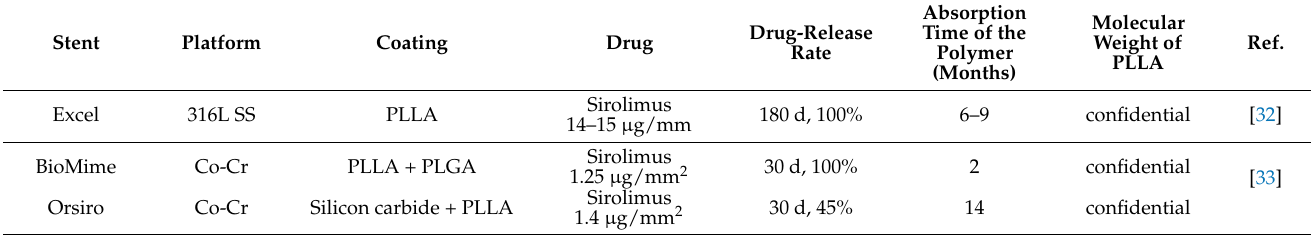
Table 1. DESs with poly-L-lactic acid (PLLA).